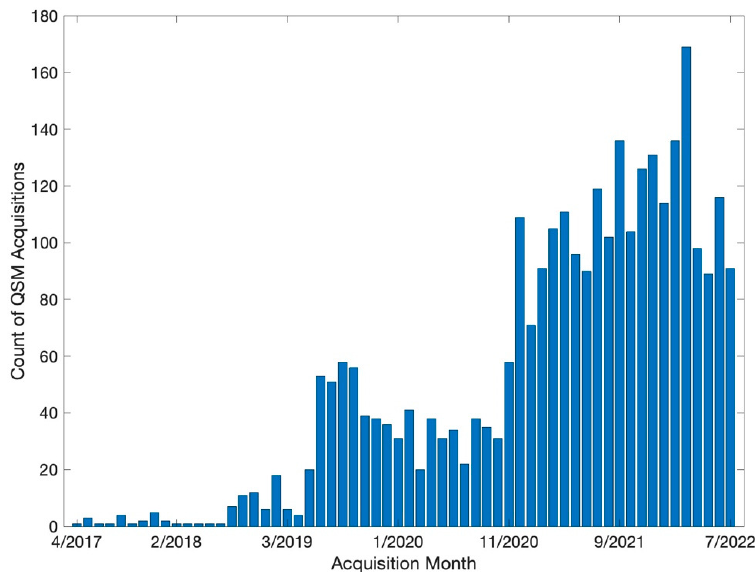
Figure 4. Number of cases acquired versus month they were acquired. The workflow and processes we describe are sufficient for high-volume acquisition and analysis of QSM data. This diagram shows a generally linear trend in study volume since 2019, with an interruption during the stages of the COVID-19 pandemic.